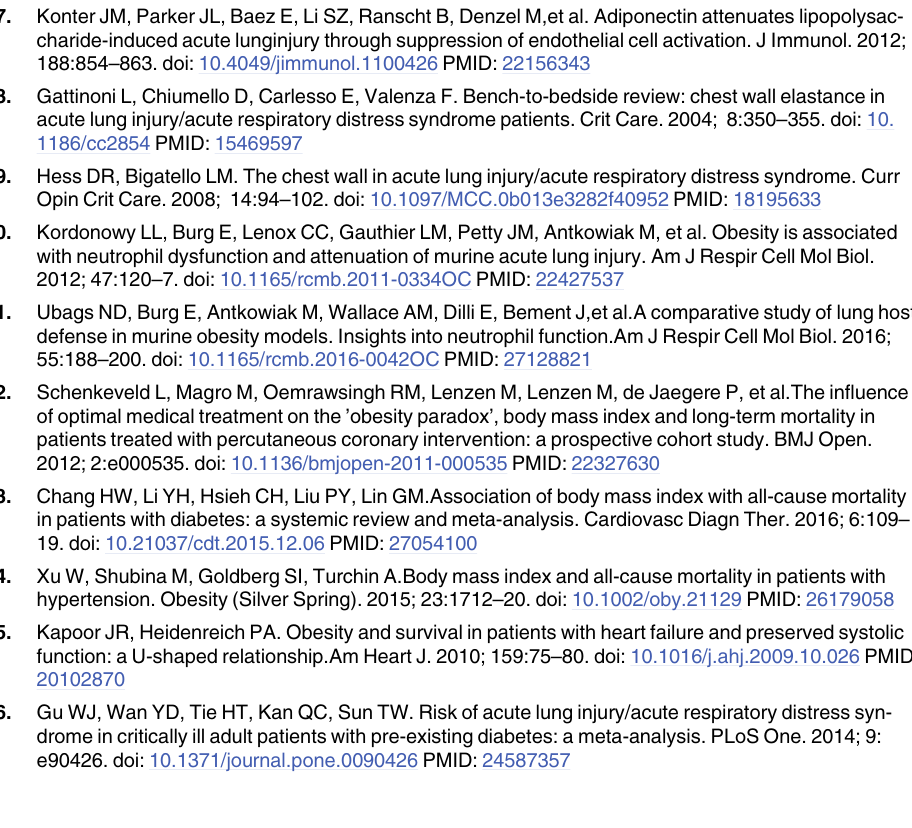
PLOS ONE | DOI:10.1371/journal.pone.0163677 September 29,